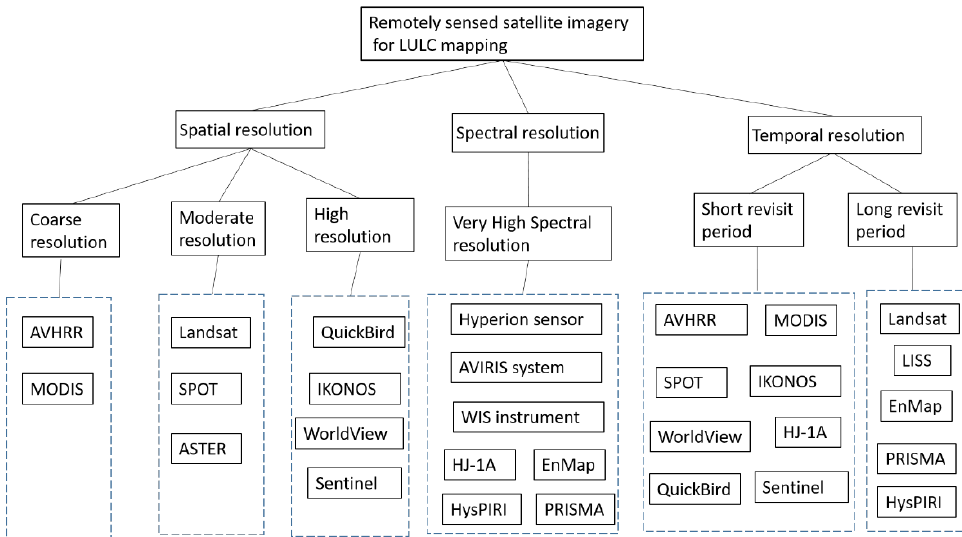
Figure 2. Different types of remotely sensed satellite imagery for LULC